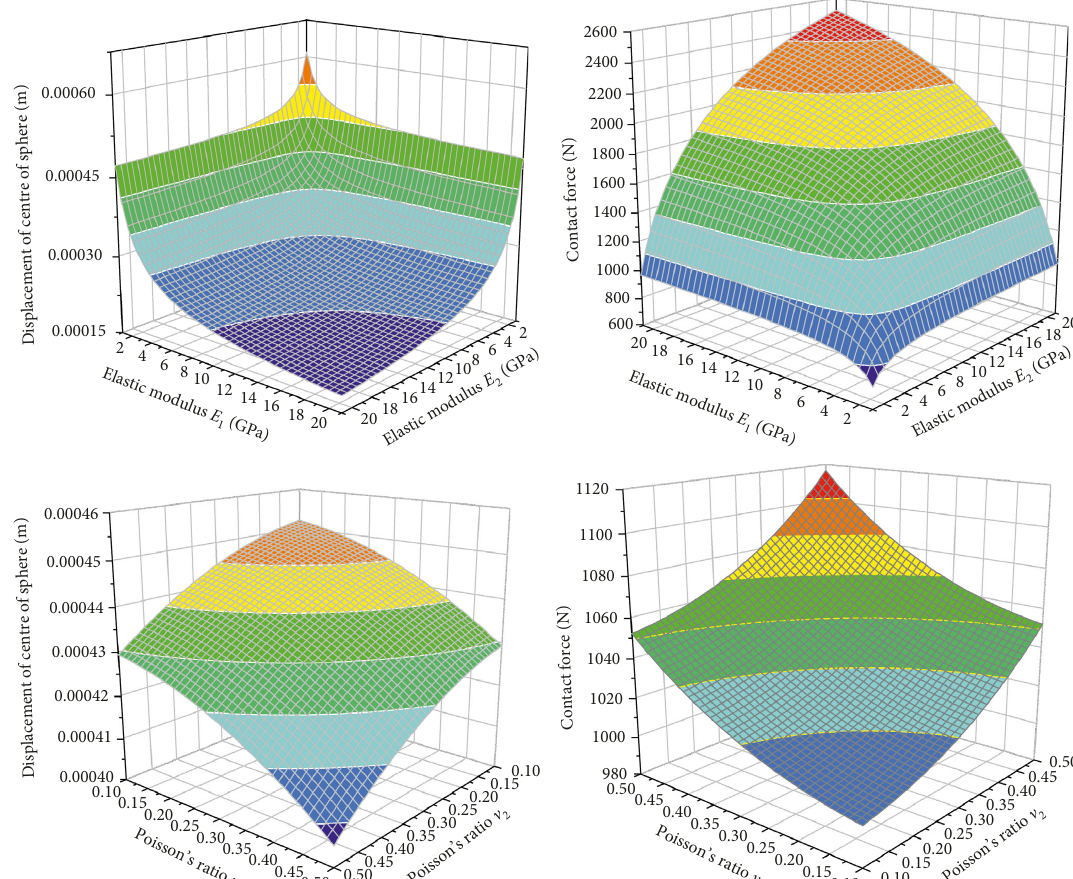
Figure 14: Effect of contactants’ parameters on DCS and contact force in the contact process of elastic sphere impacting the elastic plate (when the elastic modulus and Poisson’s ratio of the sphere are same with the plate).